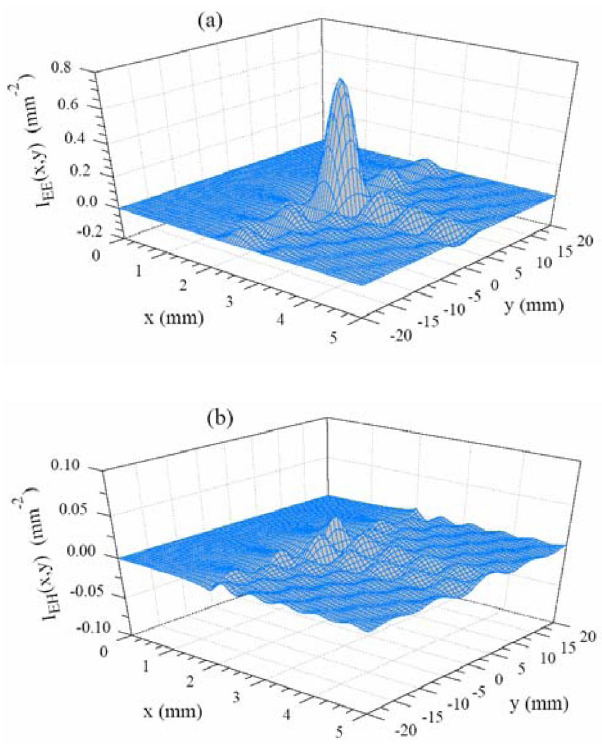
(cid:1) x; y (cid:2) EH